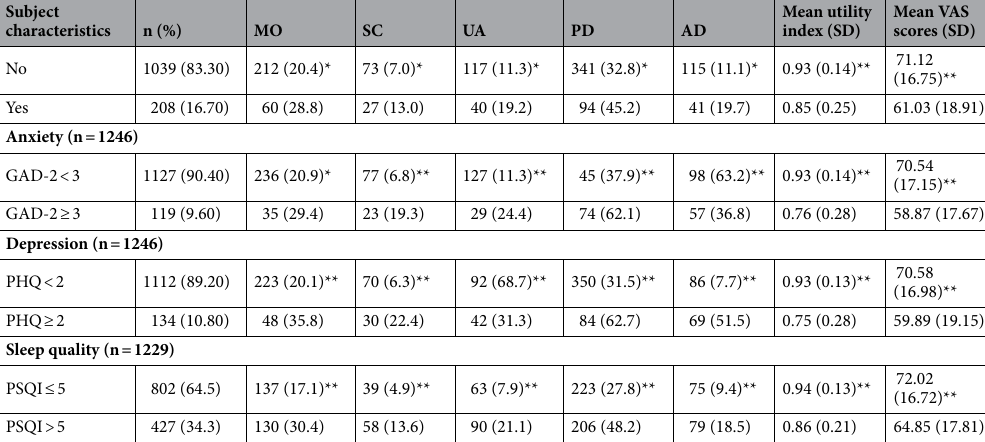
Table 2. Prevalence of having problems in each EQ-5D dimension among patients with CHD (n = 1247). CHD coronary heart disease, MO mobility, SC self-care, UA usual activities, PD pain/discomfort, AD